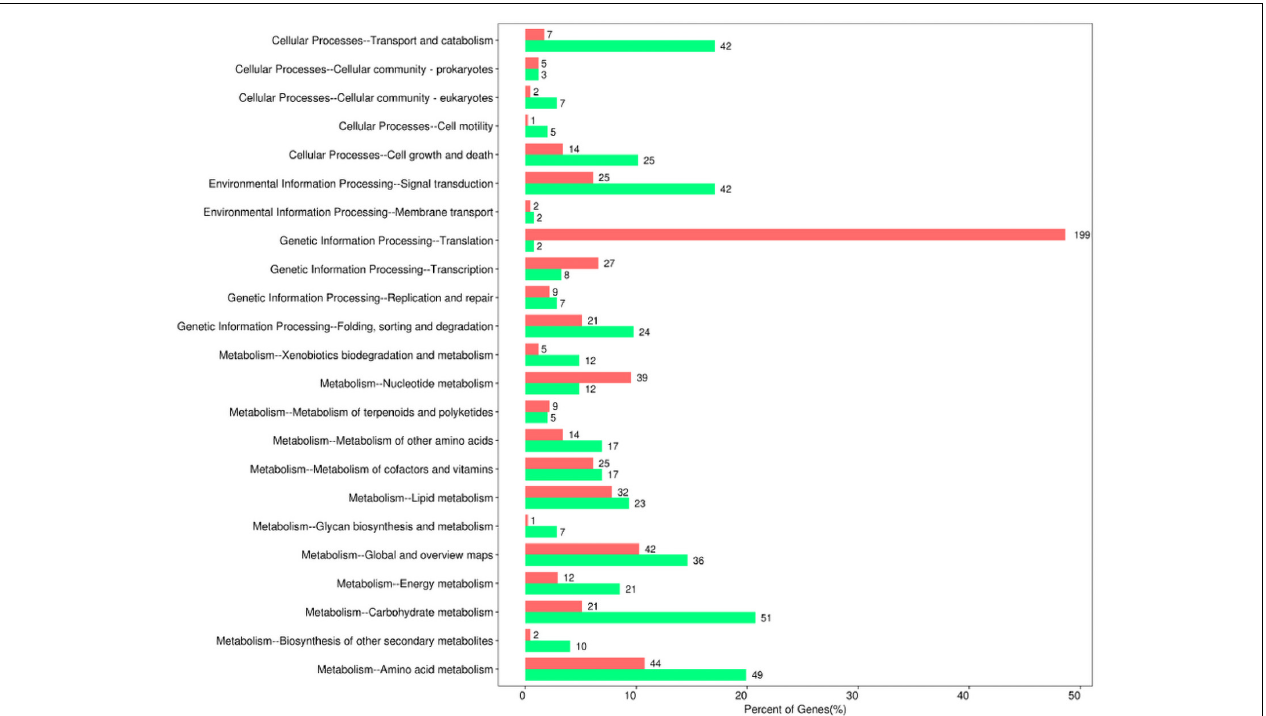
FIGURE 4 | Kyoto Encyclopedia of Gene and Genomes (KEGG) pathway enrichment of differentially expressed genes between sensitive and resistant strains. Red represented upregulated genes, and green represented downregulated